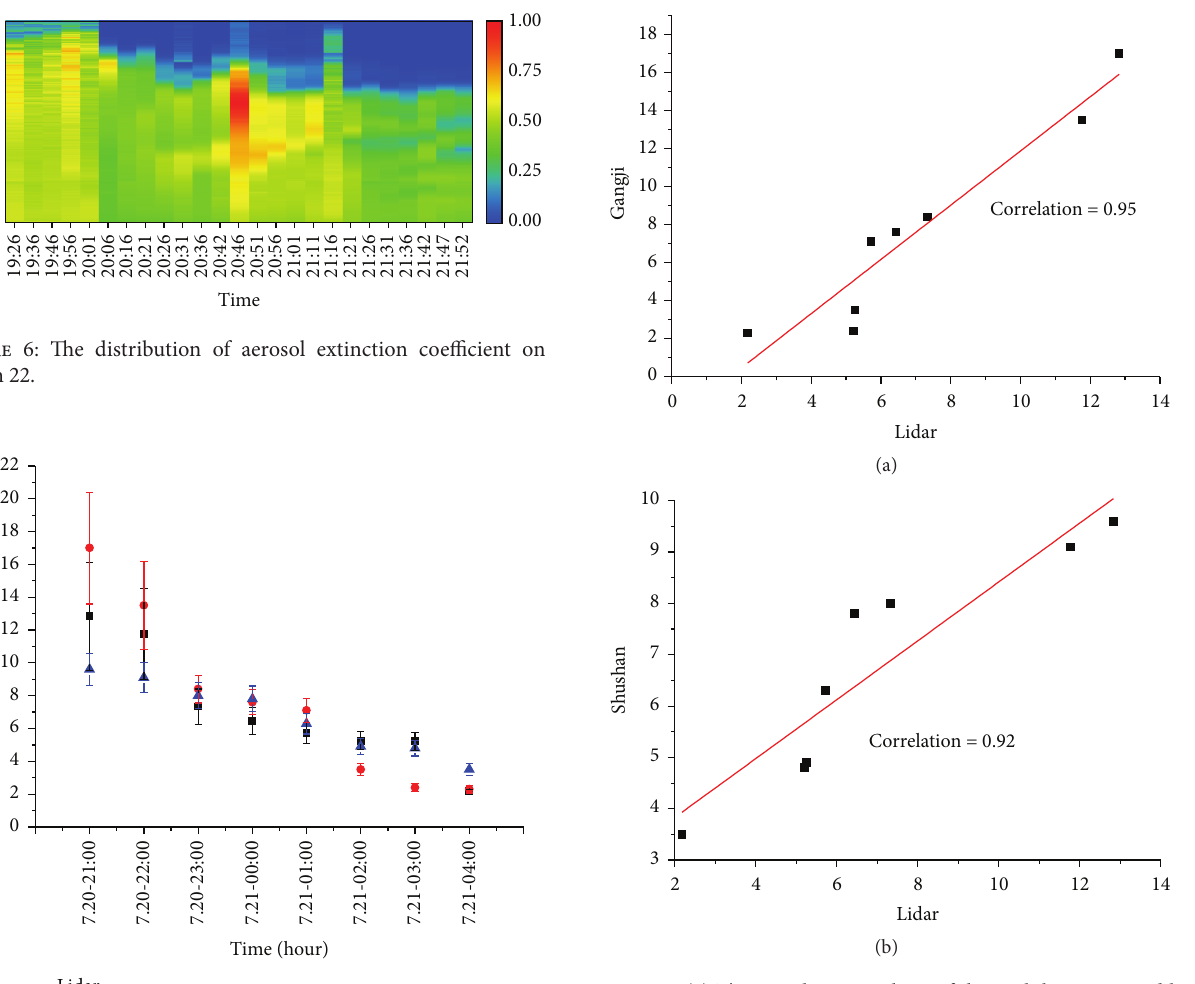
Figure 8: (a) The correlation analysis of the visibility measured by the dual field of view lidar and a forward scatter visibility meter located at Gangji station. (b) The correlation analysis of the visibility measured by the dual field of view lidar and a forward scatter visibility meter located at Shushan